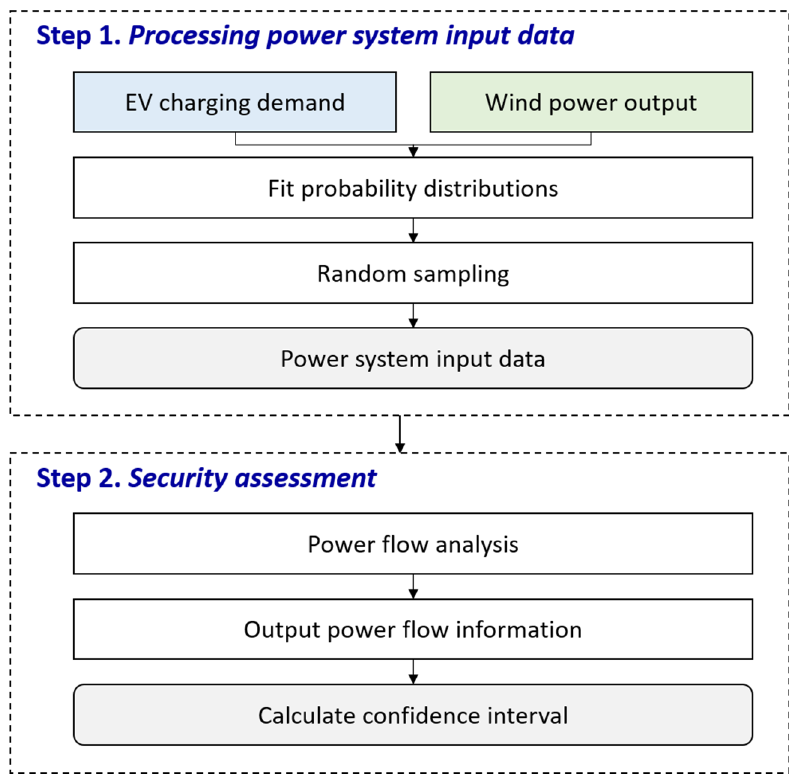
Figure 1. Process of the power-system security assessment based on probabilistic analysis.